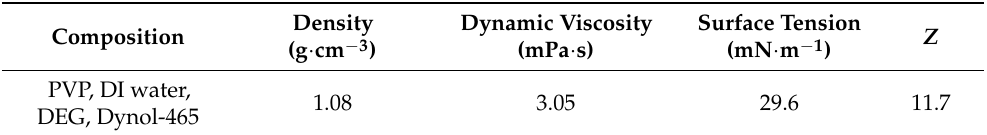
Table 4. Composition and fluid physical properties of the PVP binder ink, together with the computed value of the dimensionless number Z , taking the characteristic length to be the diameter of the printing orifice (40 µ